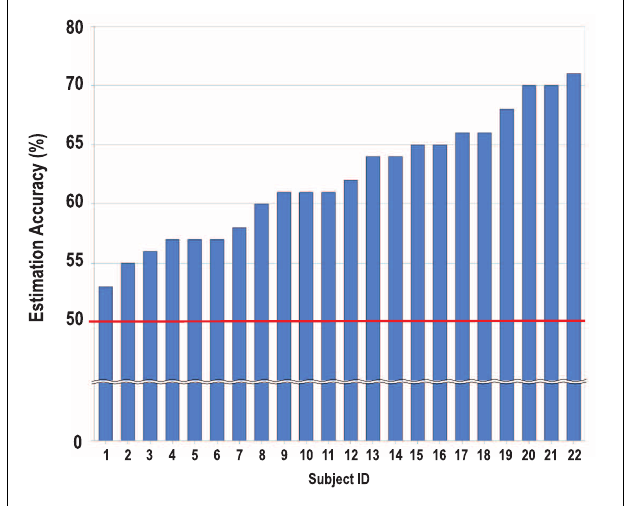
FIGURE 2 | Estimation accuracy scores of the individual perceivers. All perceivers reached above chance level (50%, shown on the red line) [ M = 62 . 18 ± 5 . 19, t ( 21 ) = 11 . 00, p < 0 .